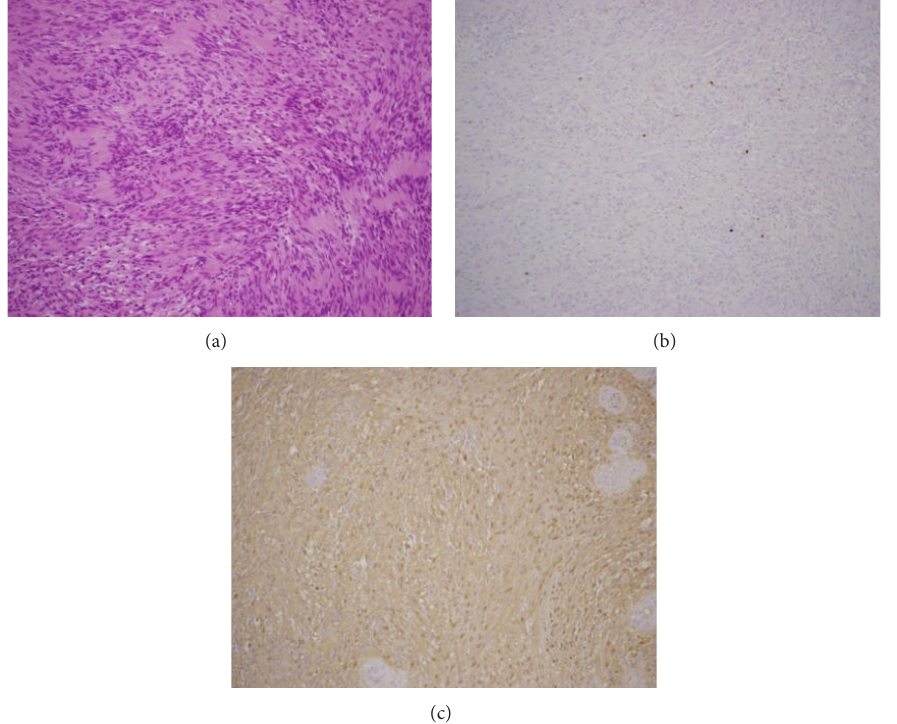
Figure 12: Histopathological images. (a) H-E staining × 200. (b) Ki-76 × 200. (c) S-100 ×